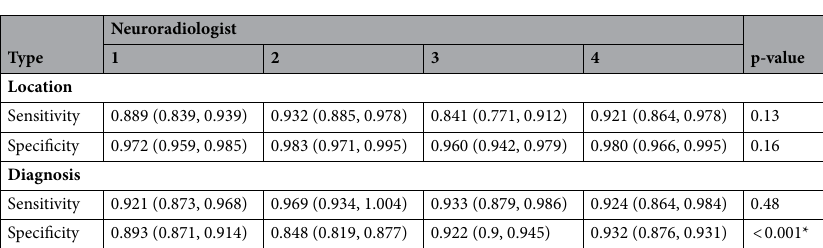
Table 5. Validity according to neuroradiologist. Asterisk indicates statistical